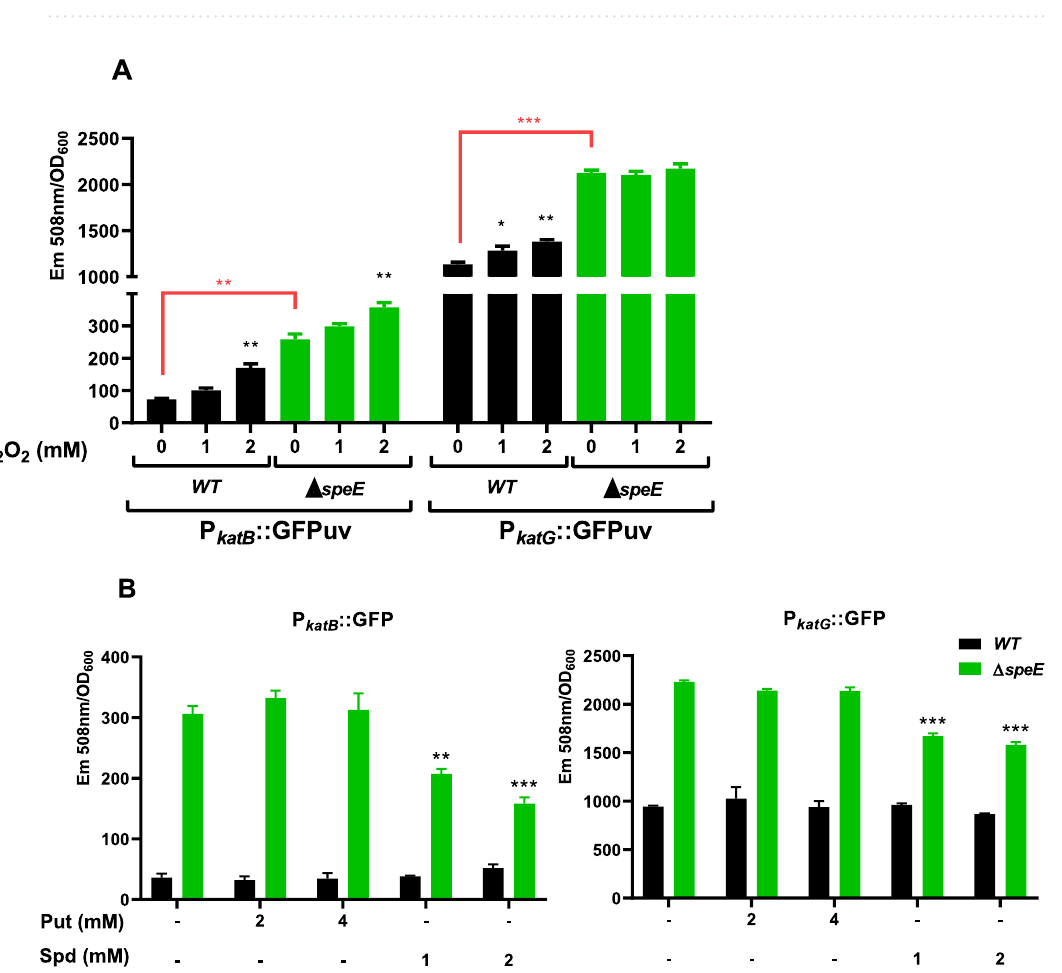
Figure 9. Catalase promoter activities in Pst DC3000 in response to H 2 O 2 and polyamines. ( A ) Cells from the wild type and ∆ speE mutant expressing the mentioned reporter constructions were exposed to different concentrations of H 2 O 2 and the emission of fluorescence at 508 nm determined after 1 h. The same approach was used in ( B ), but cells were challenged with 2 mM of H 2 O 2 in the absence or presence of polyamines at the indicated concentrations. Data of fluorescence in H 2 O 2 -treated cells were compared to their respective controls (without H 2 O 2 or polyamine-amendment). Additionally, values in control cells from different strains were compared in ( A ) (black square brackets). **p < 0.01, ***p <